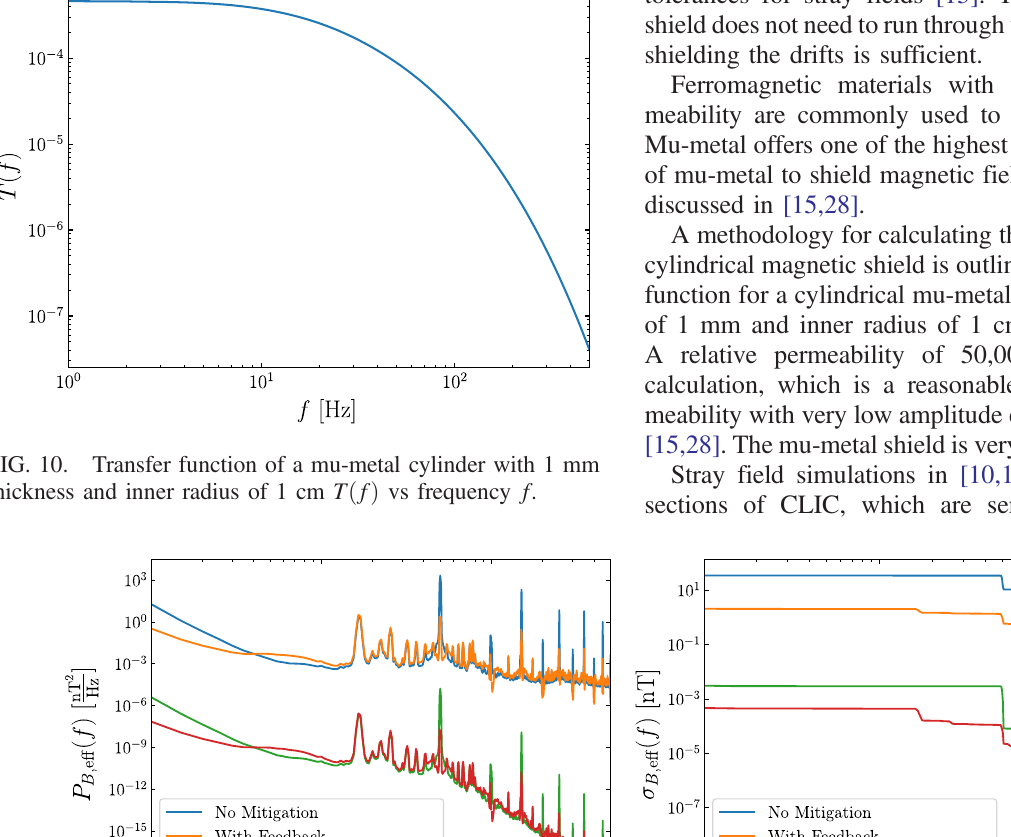
f Þ vs frequency f : without mitigation B; eff ð